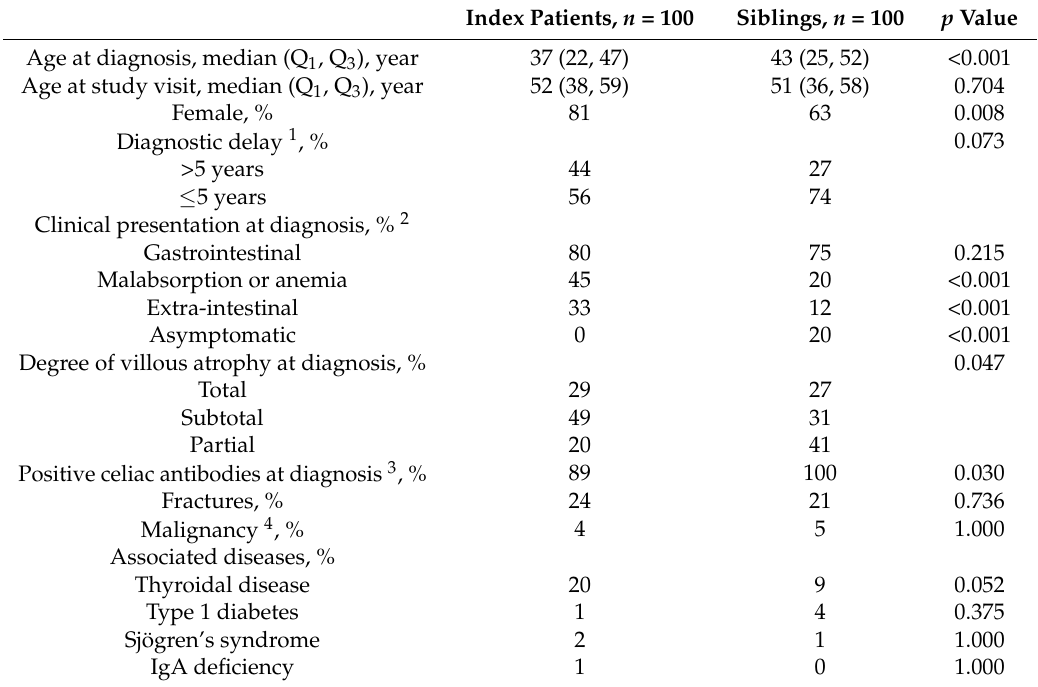
Table 1. Diagnostic characteristics and presence of complications and comorbidities in 100 sibling pairs with celiac disease.